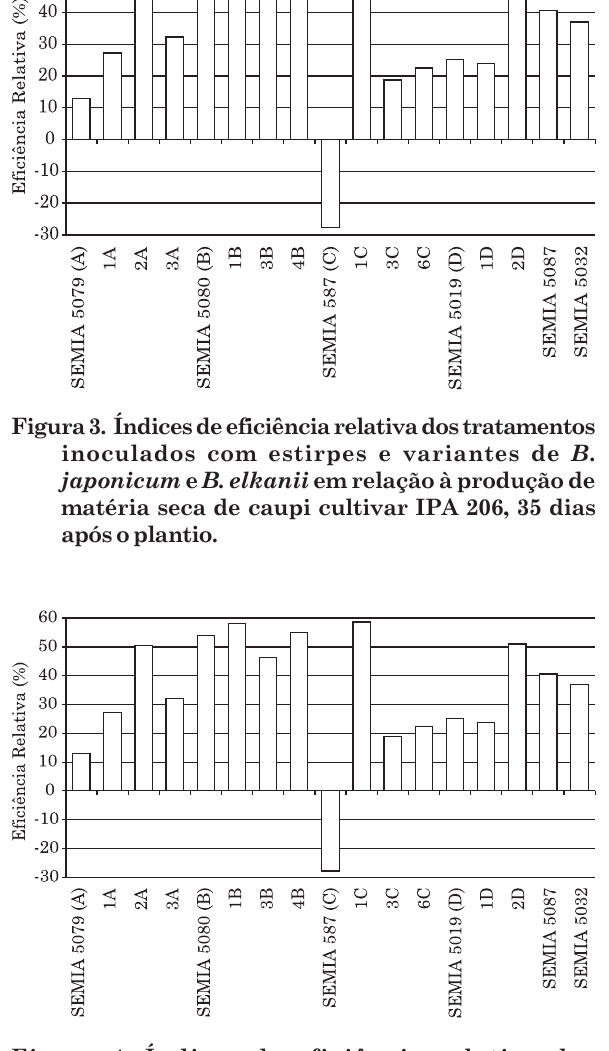
Figura 4. Índices de eficiência relativa dos tratamentos inoculados com estirpes e variantes de B. japonicum e B. elkanii em relação à produção de matéria seca de guandu, 35 dias após o